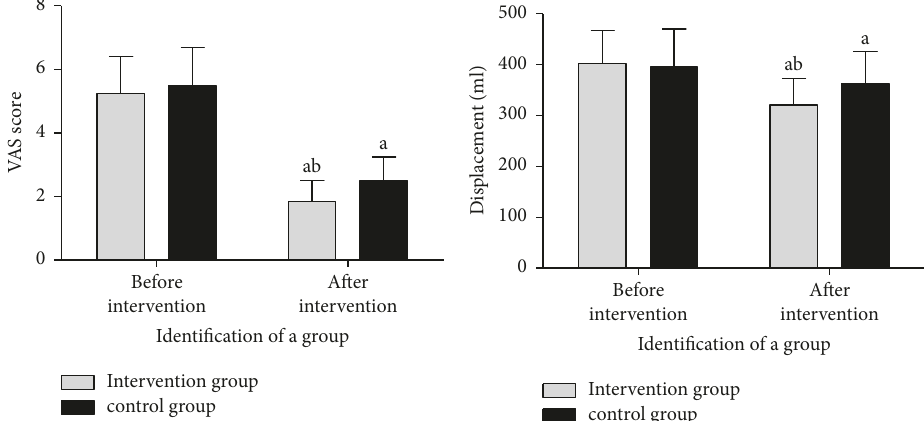
Figure 2: Comparison of the VAS and swelling degree of the affected hands between the two groups before and after intervention (Note: compared with the group before treatment, a P < 0 . 05; compared with the control group, b P < 0 .